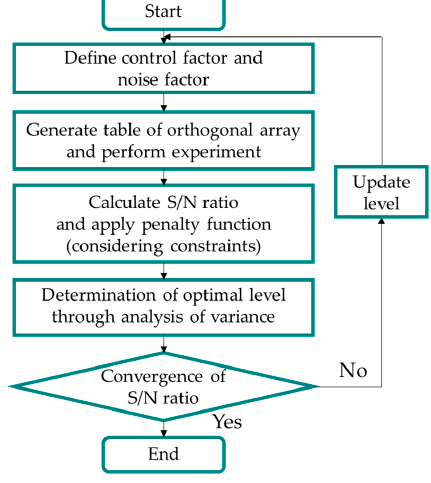
Figure 5. Proposed RDO algorithm.